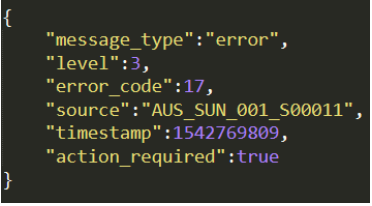
Figure 15. Error packet sample.